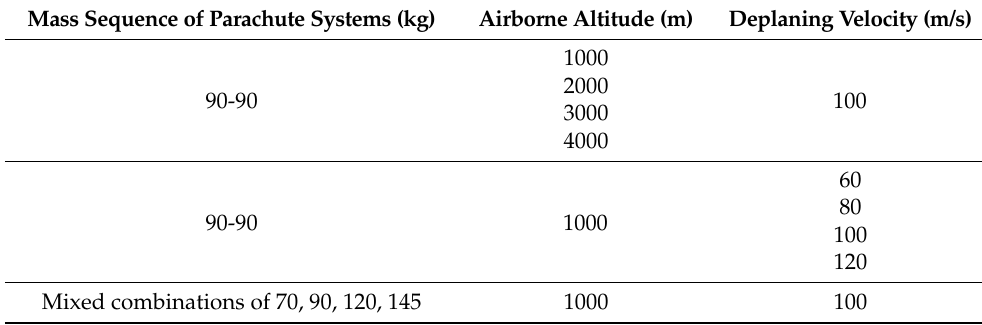
Table 3. Airborne conditions of the clusters. Mass Sequence of Parachute Systems